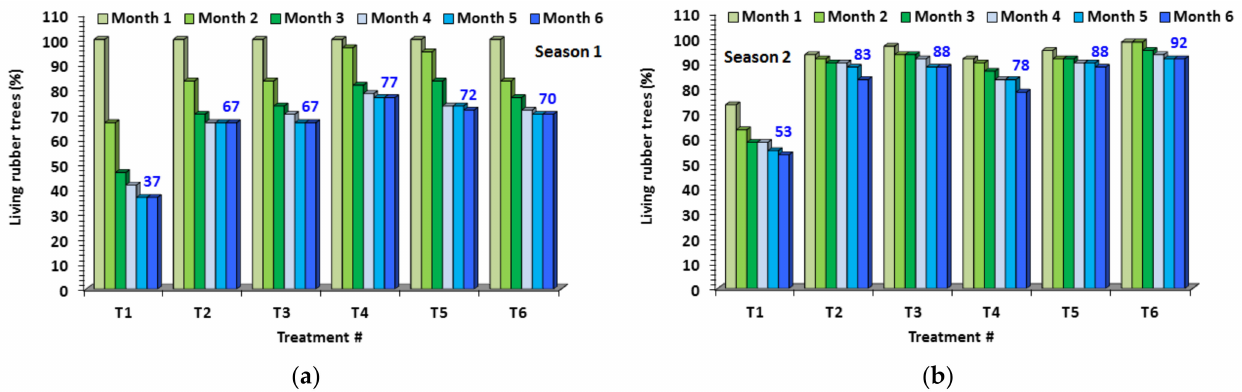
Figure 8. ( a ) Effects of SWA on percentage of living rubber trees from the experiment performed during season 1 after 6 months, without watering; ( b ) effects of SWA on percentage of living rubber trees from the experiment performed during season 2 after 6 months, without